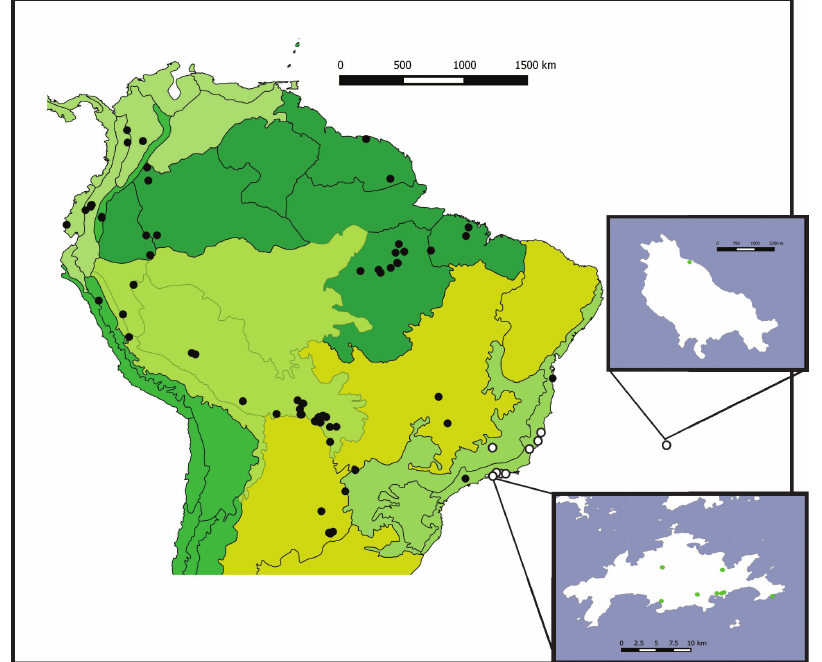
Figure 1 - Area of distribution of the genus Solaropsis . Biogeographical regionalization of Morrone (2014) at the Dominion level. Shapefile implementation according to Lowënberg-Neto (2014). Biogeographic dominions: Yungas; Boreal Brazilian; Chacoan; Pacific; Paraná; South Brazilian. ● = Solaropsis species records; ○ = Solaropsis brasiliana